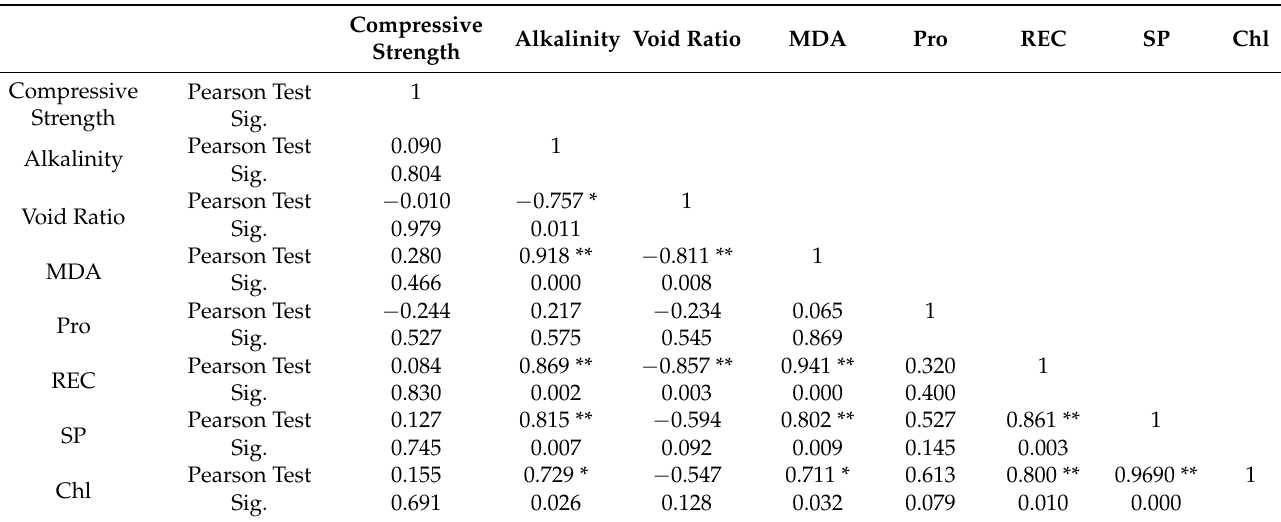
Table 5. Correlation coefficients between physical indexes and plant physiological indexes, n = 9 (Group SC).